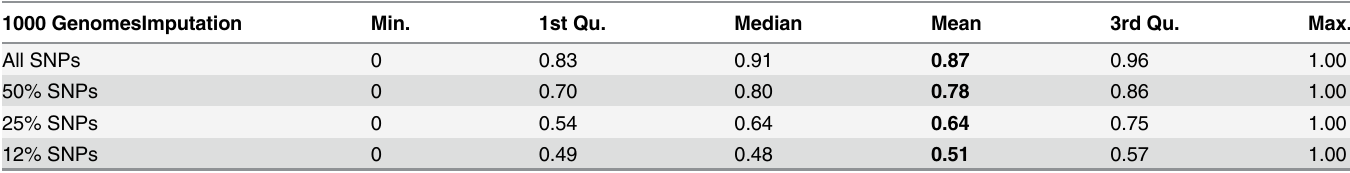
Shown are the mean and quartiles of the distribution of estimated R 2 values (IMPUTE2 info scores) for imputation of all variants found in the 1000 Genomes Study with frequency > 1% in African populations. The imputation basis consists of all (pruned) non-causal SNPs and randomly chosen